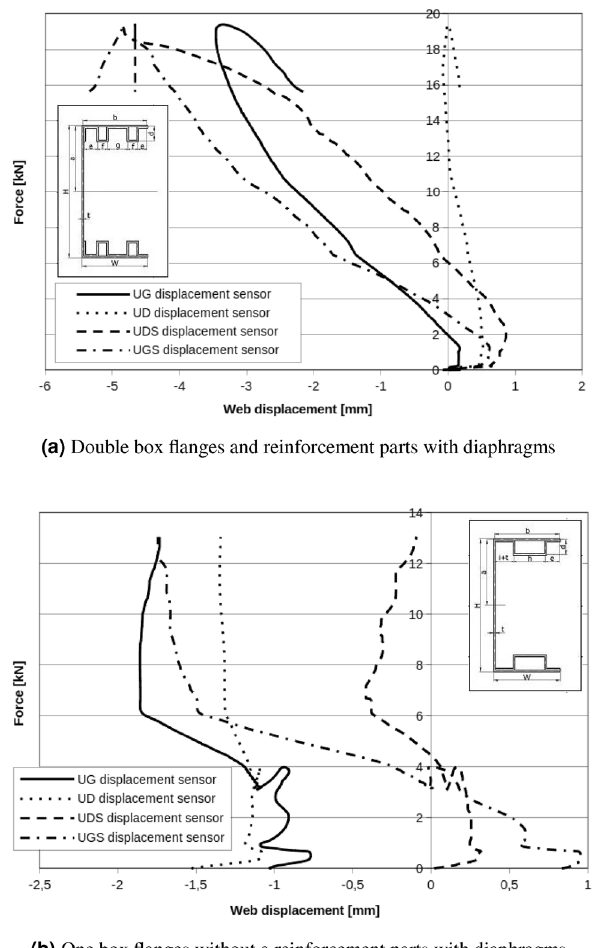
Figure 16. Web displacement points. UG—displacement of the upper web point on the fixed stiff steel plate, UD—displacement of the lower web point on the fixed stiff steel plate, UGS— displacement of the upper web point on the movable stiff steel plate, UDS—displacement of the lower web point on the movable stiff steel